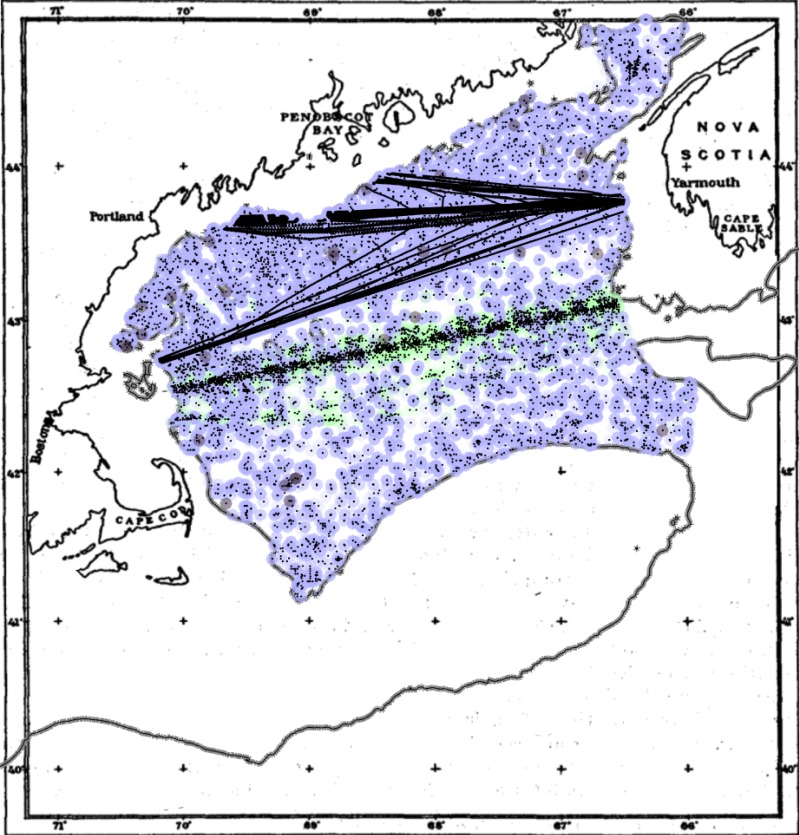
Sample locations for the compiled phytoplankton dataset in the inner Gulf of Maine.Points are back-colored by original measurement type: FU (grey), PCI (green), chlorophyll (blue). Background map adapted from (Bigelow, 1924a). The grey line is updated 100 m isobath.